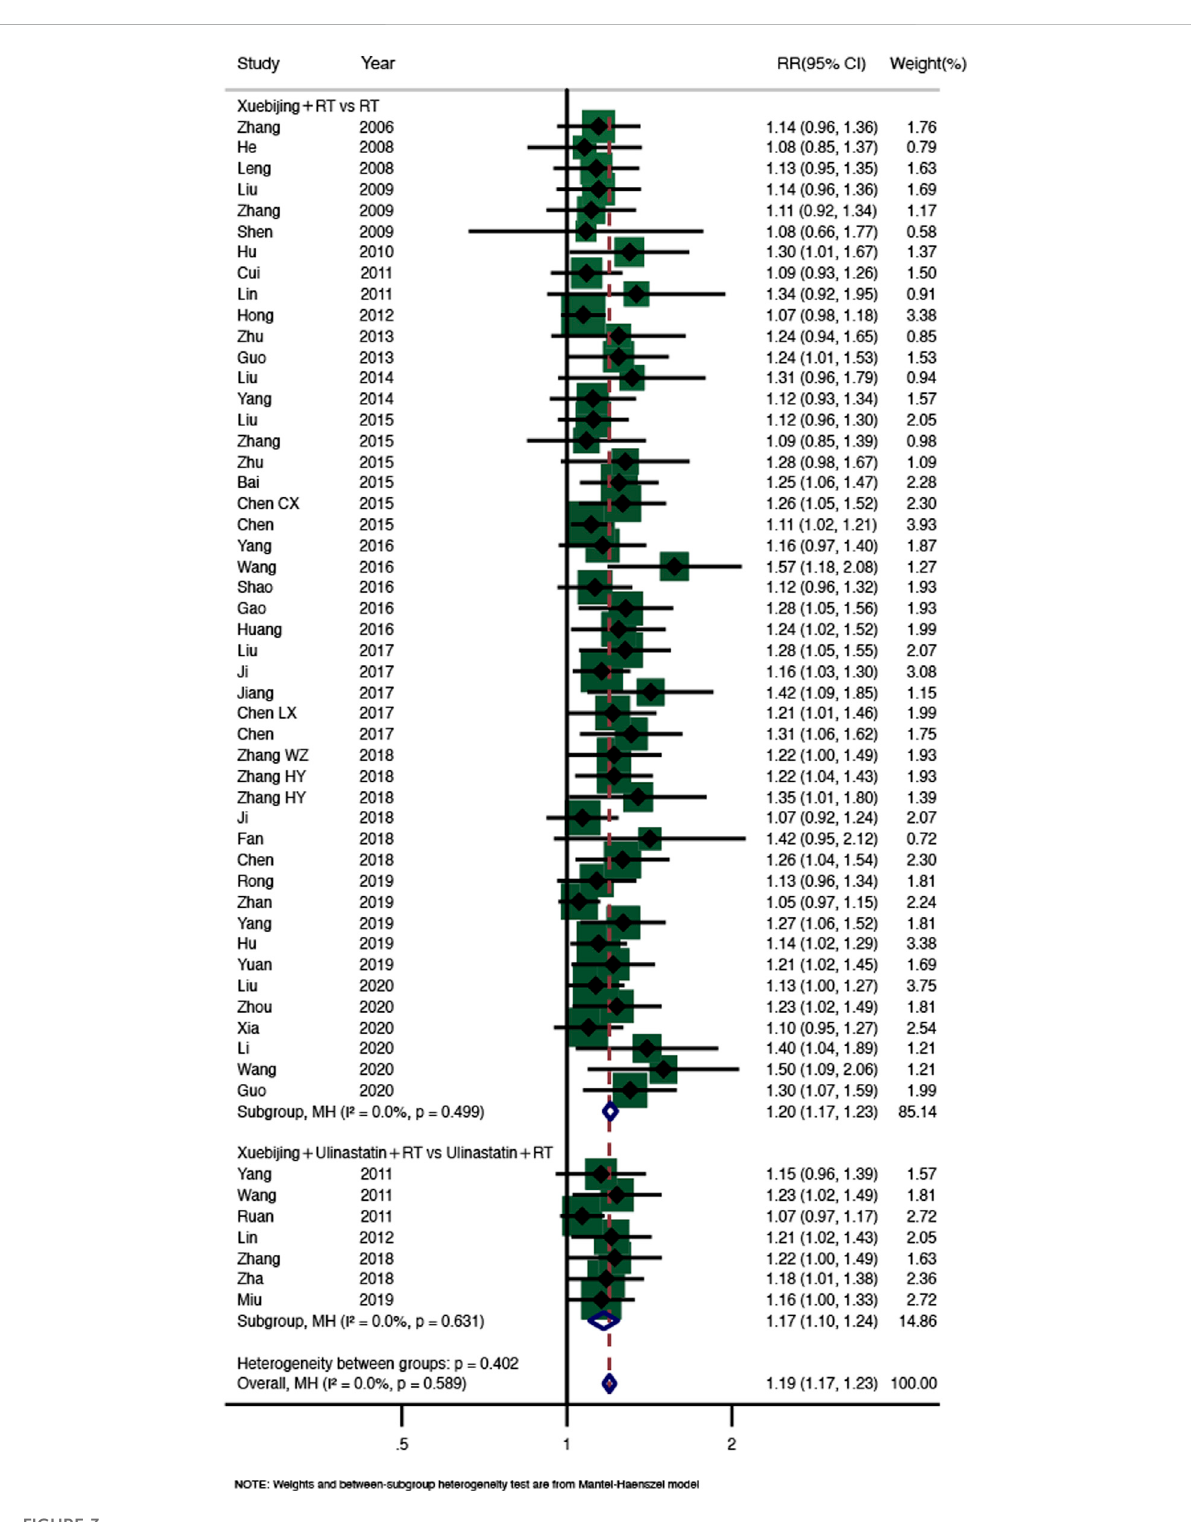
FIGURE 3 Meta-analysis of total effectiveness